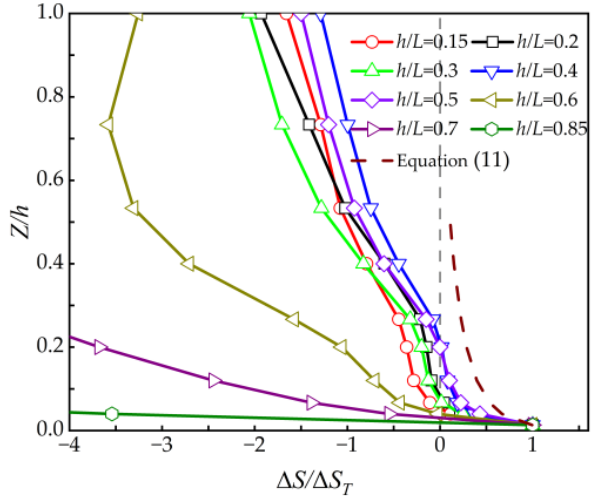
Figure 16. Dimensionless speedup ratio at vertical height.